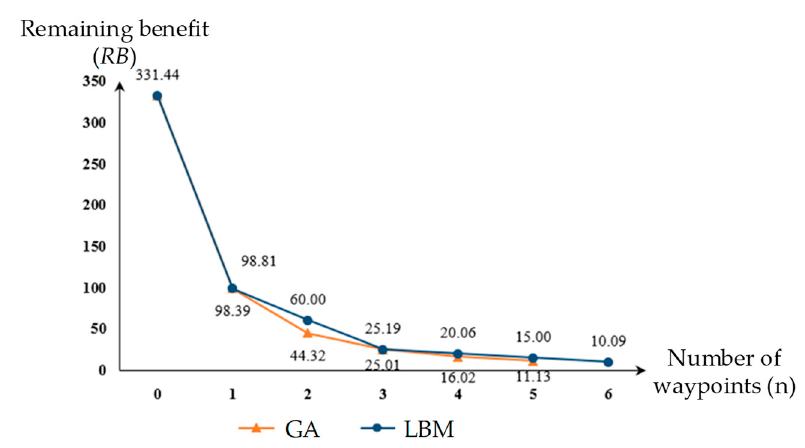
Figure 7. Comparison of the GA method and longitude bisection method (LBM).